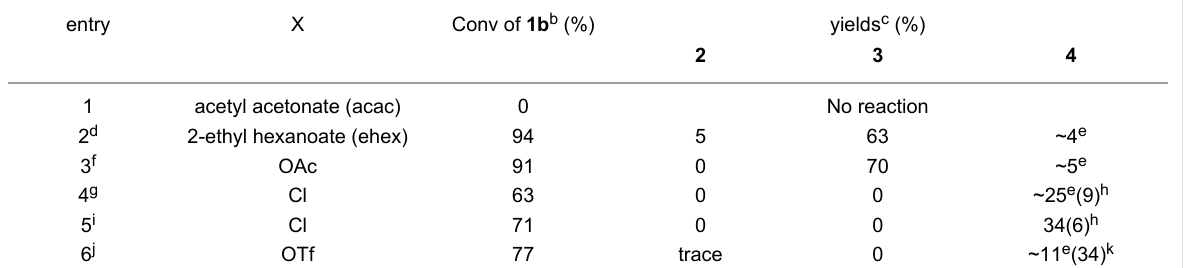
Table 2: Reaction of cyclopropanol 1b with various copper(II) salts (CuX 2 ). a